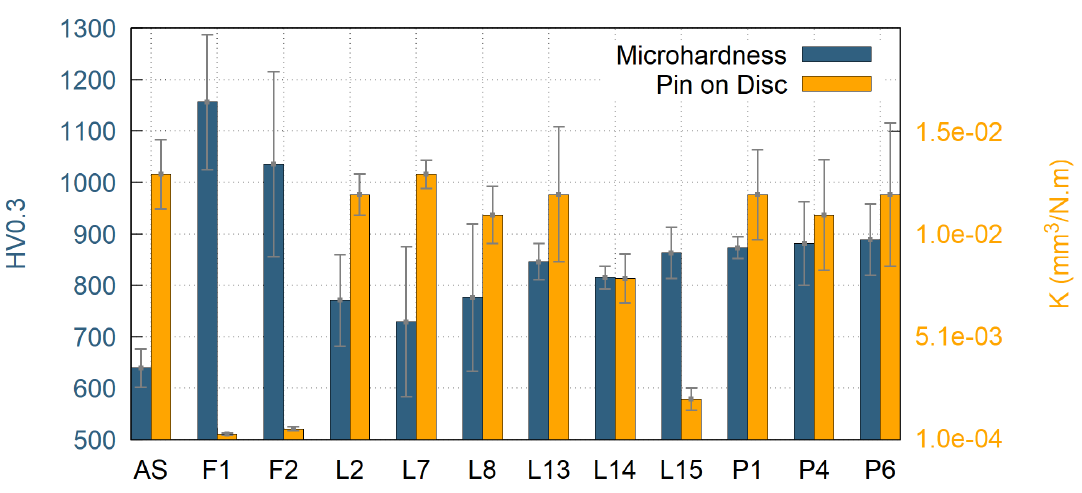
Figure 8. Microhardness and Pin on Disc volume loss for as-sprayed, furnace treated, laser treated and plasma treated samples.